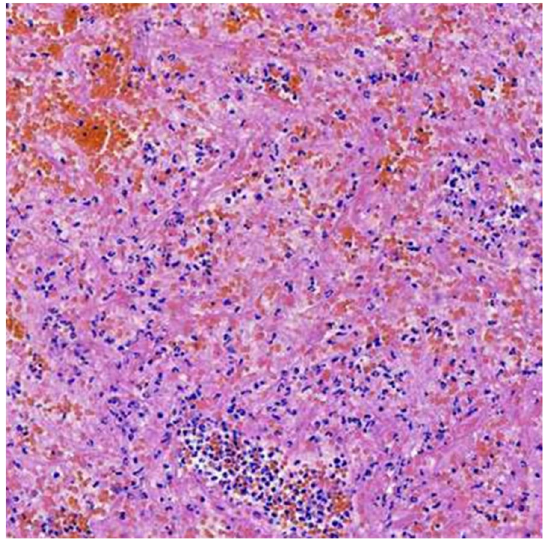
Fig. 4 Microscopically, a reddish fibrin network is seen, and the stroma is full of red blood cells and